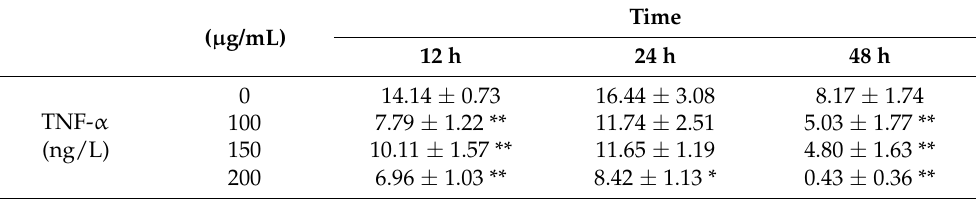
Table 13. Effect of different concentrations of GSP on TNF- α mRNA expression in mature